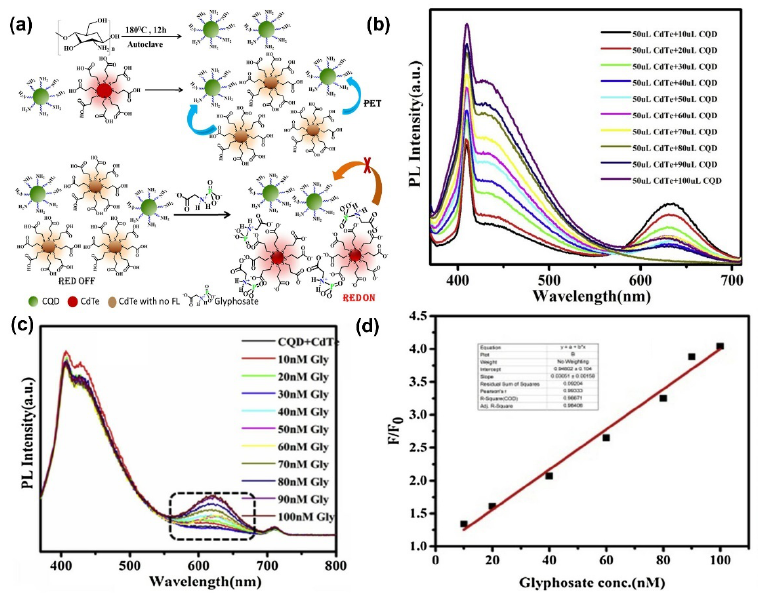
Figure 17. ( a ) The sensing mechanism of CdTe-CQD sensor towards GLYP, ( b ) Fluorescence decreasing of CdTe due to increasing concentration of CQD solution ( c ) Fluorescence response of CdTe CQD solution, ( d ) Linear range. Reprinted with permission from [157]. Copyright 2020 Elsevier.